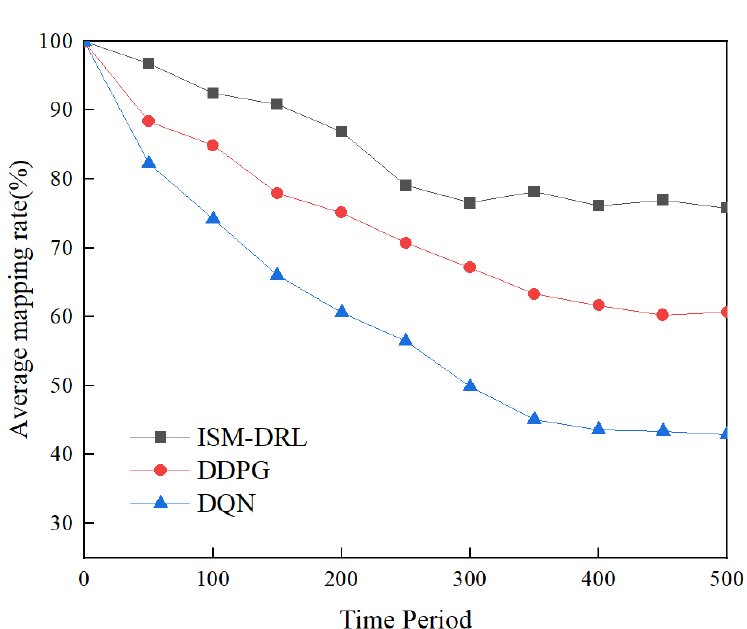
Figure 6. Average mapping rate at α 1 = 0.3, α 2 = 0.7.